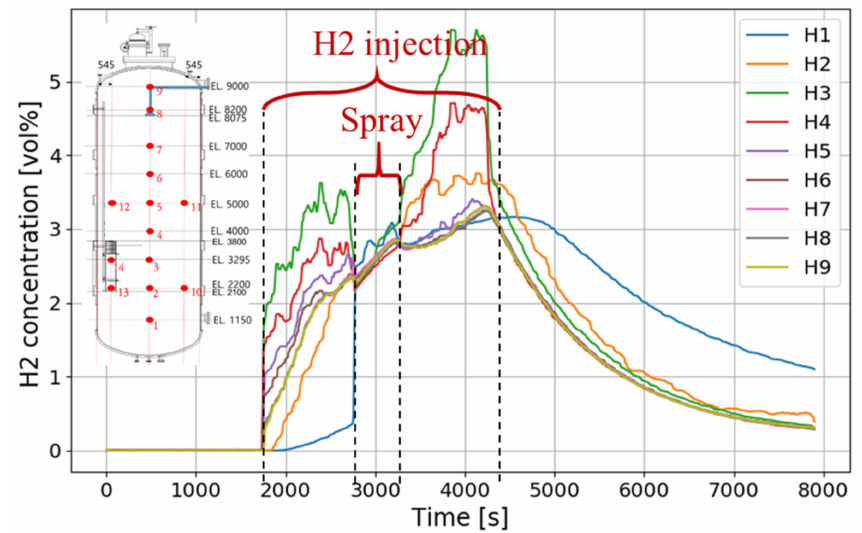
Figure 23. Time variations in the hydrogen concentrations during the SSP4